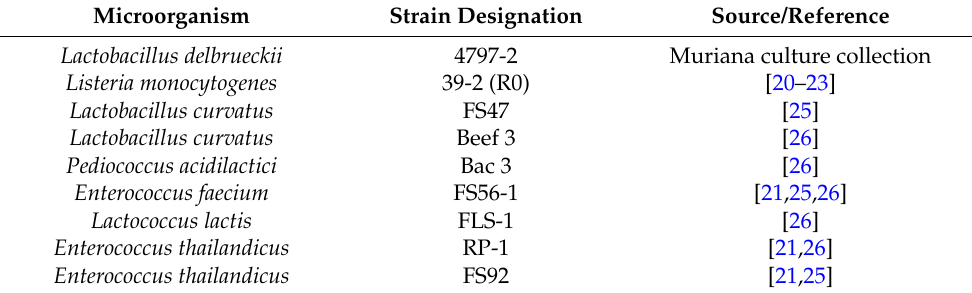
Table 1. Bacterial strains used in this